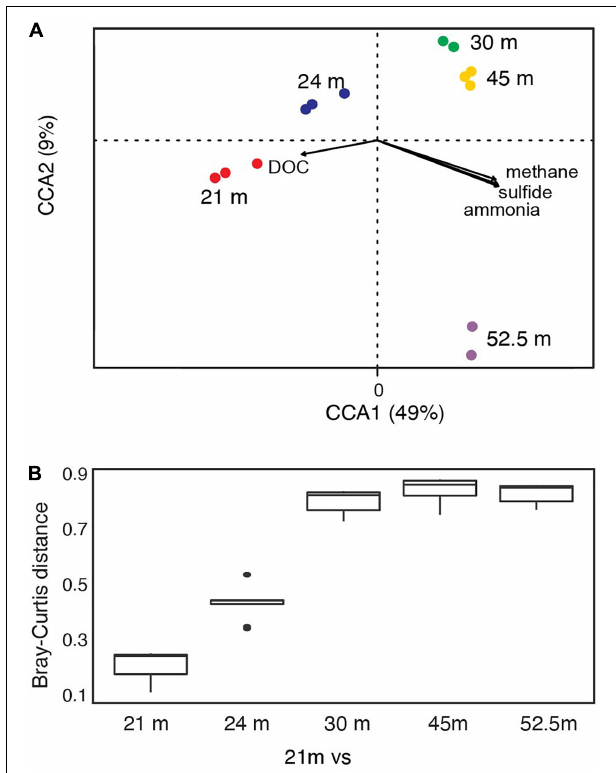
FIGURE 3 | FGL biogeochemistry drives microbial community structure along the water column. (A) CCA analysis correlating bacterial community structure at the sampled depths with geochemical gradients. Only the two primary CCA axes are shown and samples are color-coded by depth. Arrows indicate the direction and magnitude of the relationship (ANOVA: sulfide F = 22.71, p = 0.001; methane F = 8.07, p = 0.003; ammonia F = 2.69, p = 0.06; DOC F = 2.48, p = 0.09). (B) Bray–Curtis dissimilarity between 21 m and all other sampled depths ( n for each depth = 3, except for 30 and 52.5 m where n =